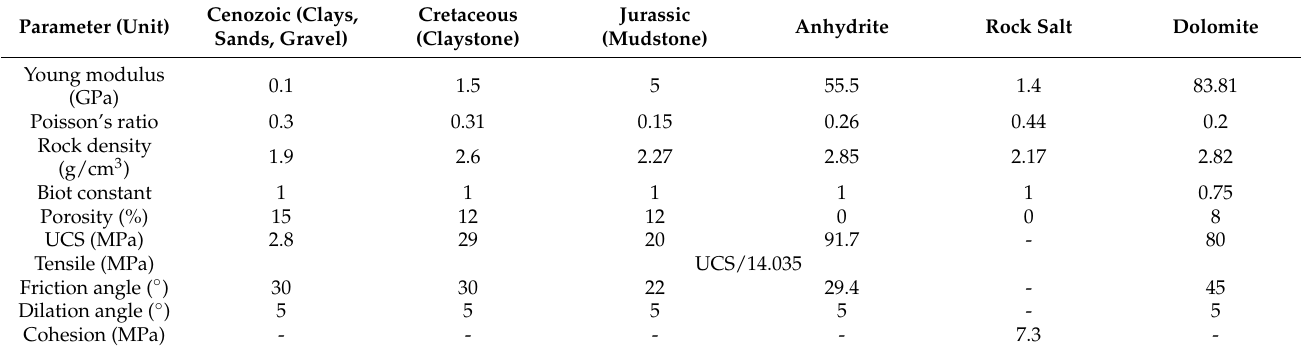
Table 5. Assumed values of elastic and strength properties for overburden rocks